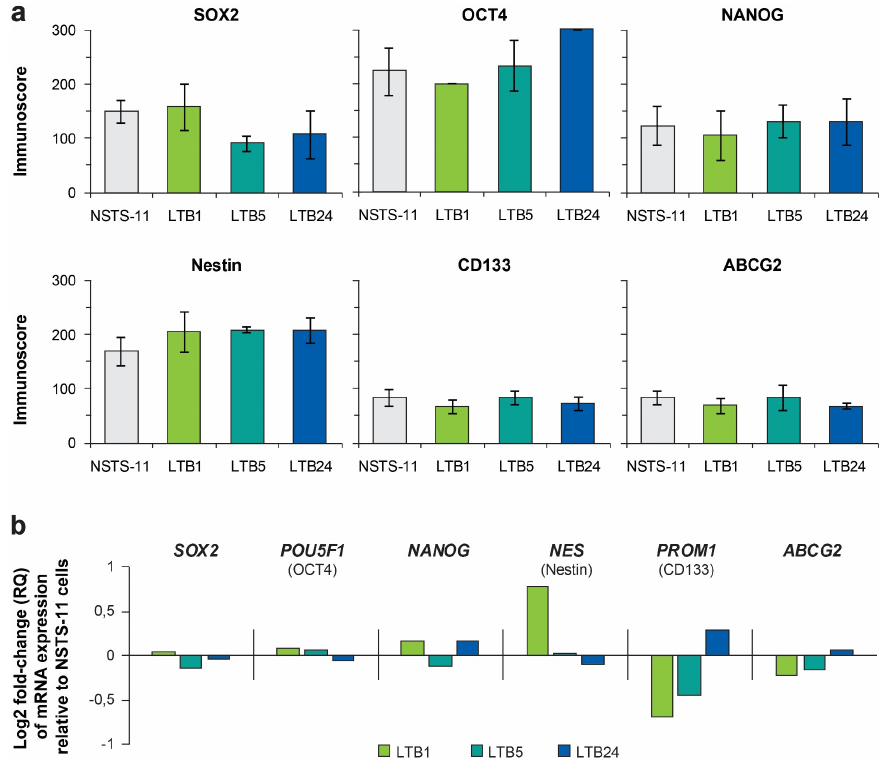
Figure 4. ( a ) Immunofluorescence analysis of core pluripotency factors (upper panel) and commonly used CSC markers (lower panel). Immunoscores were determined by multiplying the percentage of positive cells by the respective immunoreactivity. Data are presented as the mean ± SD of at least three independent experiments. ( b ) Expression profiling data of genes encoding the investigated proteins. Where necessary, the protein name is noted under the official gene symbol. Table 2. Immunohistochemical analysis of primary tumor tissue and xenograft tumor tissues.